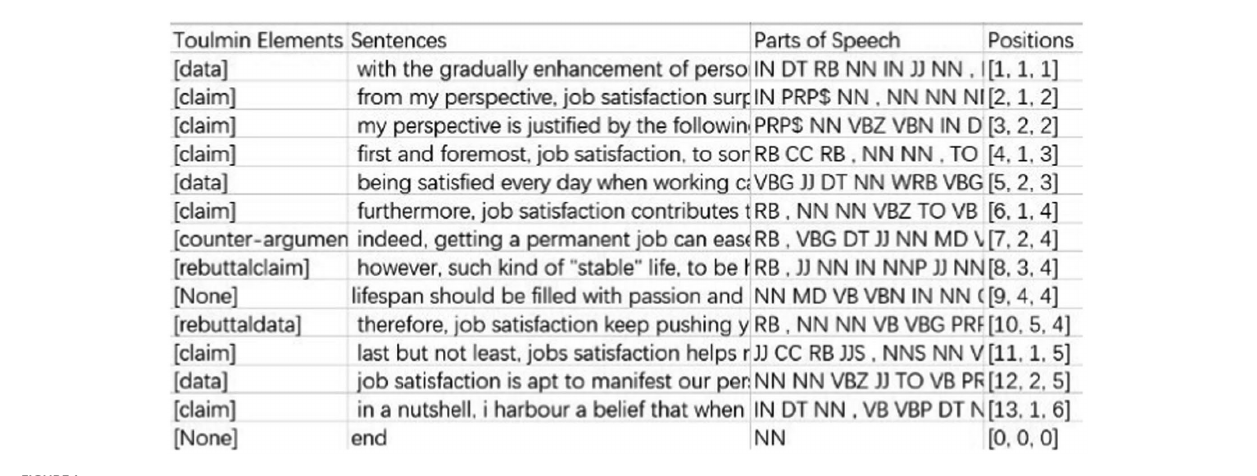
FIGURE 1 Example of processed text [ Note : The first two columns indicate the Toulmin elements and corresponding sentences; the third column represents the part-of-speech of each word in the sentence (e.g., IN refers to preposition, RB refers to adverb, NN refers to noun); the fourth column shows the position of each sentence in the text (the first number indicates the position of the sentence in the text, the second number refers to the position of the sentence in the paragraph to which it belongs, and the third number shows the position of the paragraph in the text)].